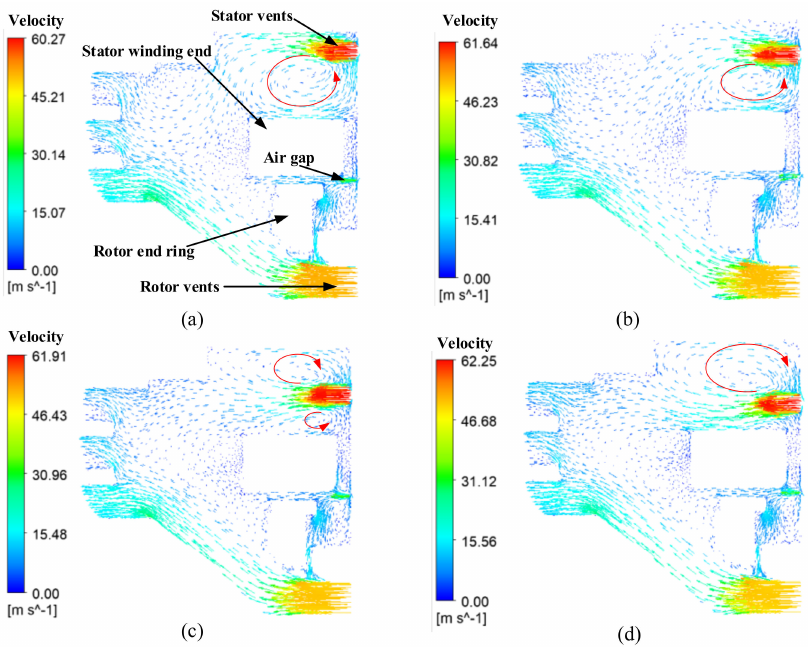
Figure 18. Velocity comparison near the outlet under schemes with varying radial position. ( a ) scheme 7; ( b ) scheme 9; ( c ) scheme 10; ( d ) scheme